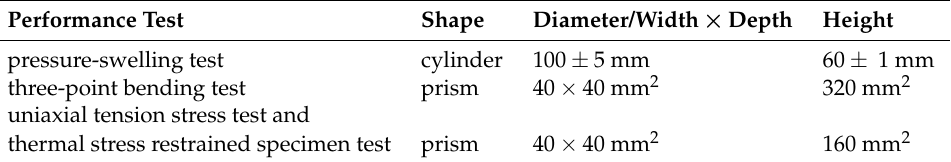
Table 2. Dimensions of tested specimens according to